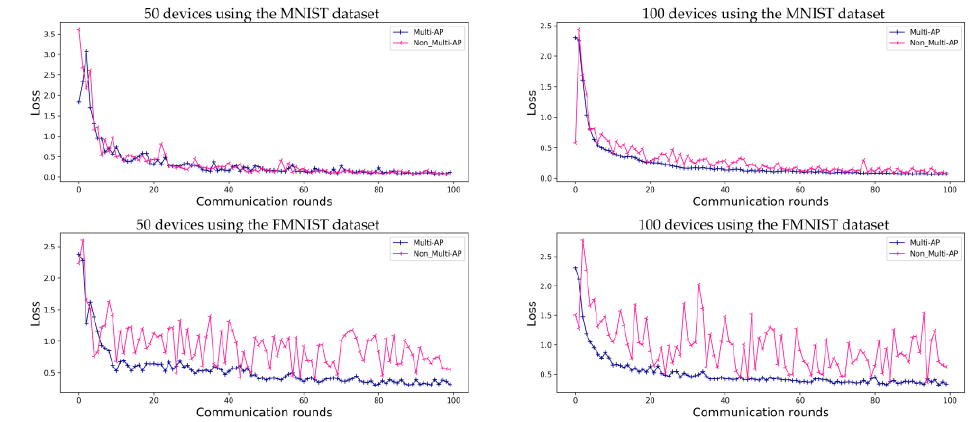
Figure 7. Evaluation of FL prediction accuracy loss using the MNIST and FMNIST datasets in envi- ronments with ten APs, for 100 communication rounds.